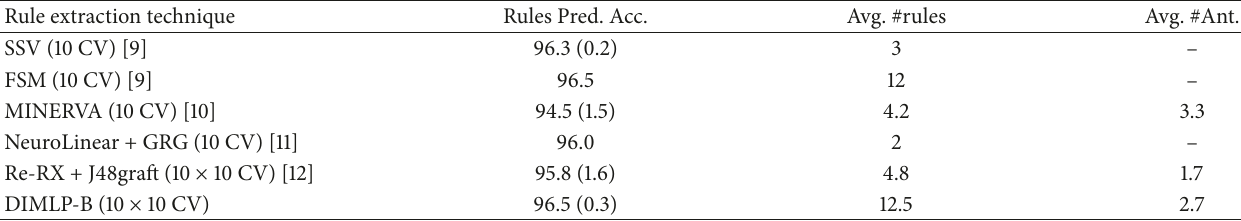
Table 11: Comparison of rule extraction algorithms for the Breast Cancer classification problem, based on 10-fold cross-validation on single networks or ensembles of neural networks (last two rows).